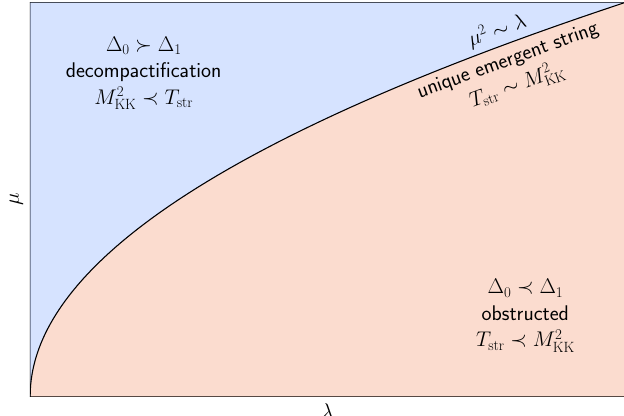
Figure 1 . In(cid:12)nite distance limits of the F-theory geometry C 0 B 3 B 2 (for the class where ! ! C 0 is a rational curve): The quantity (cid:21) parametrises a (cid:12)nite volume in(cid:12)nite distance limit in ! 1 which the volumes 0 and . The parameter (cid:22) describes an additional homogeneous V C 0 ! V B 2 ! 1 rescaling (cid:22) 3 . The plane is separated by the codimension one locus (cid:22) 2 (cid:21) at which a unique V B 3 (cid:24) (cid:24) emergent heterotic obtained by wrapping a D3 brane on C 0 becomes light at the same rate as the KK scale. The region where (cid:22) 2 =(cid:21) 0 is obstructed by (cid:11) 0 -corrections, whereas the opposite regime ! (cid:22) 2 =(cid:21) is a decompacti(cid:12)cation limit where M 2 =T str 0. Note that (cid:1) 0 and (cid:1) 1 dualise to KK ! 1 !